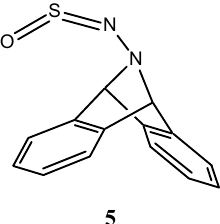
Figure 1. 7-sulfinylamino-7-azadibenzonorbornadiene Figure 1.